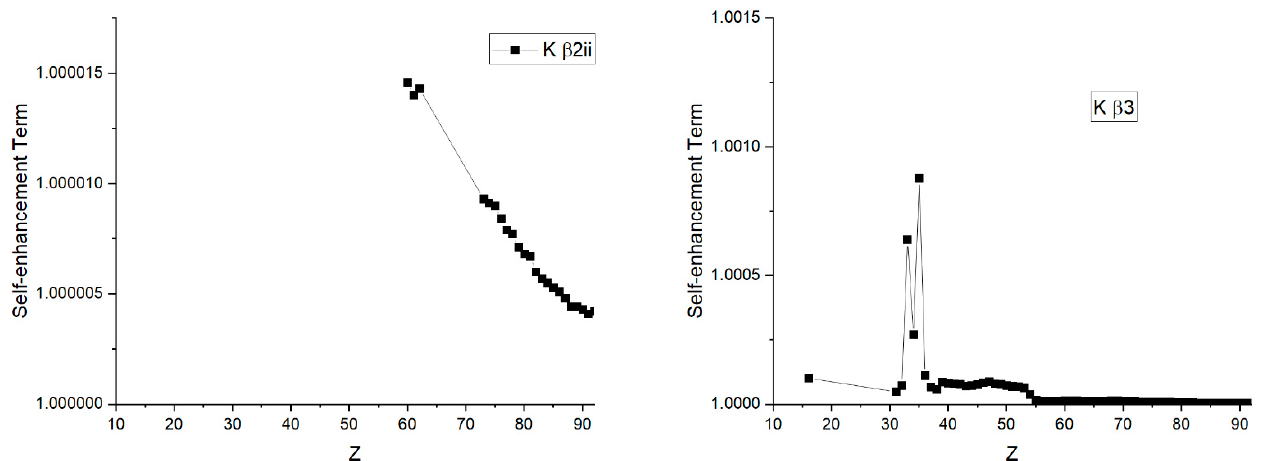
Figure 6. Self-enhancement term computed with the closed expression in Equation (30) for the K lines α1, α2, β1, β2i, β2ii, and β3. For each element, an excitation energy 10 eV higher than the cor- responding absorption edge energy was assumed. The intensity amplification was negligible for these lines.